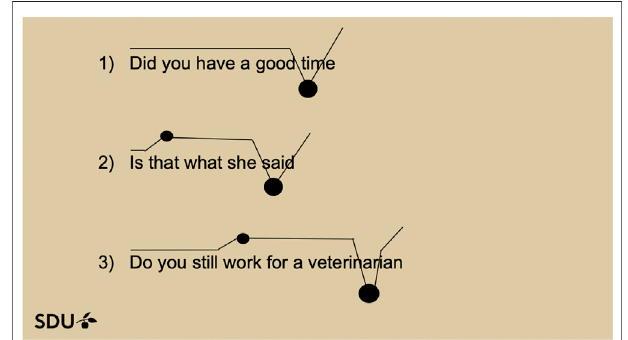
FIGURE 2 | The three questions to be produced.